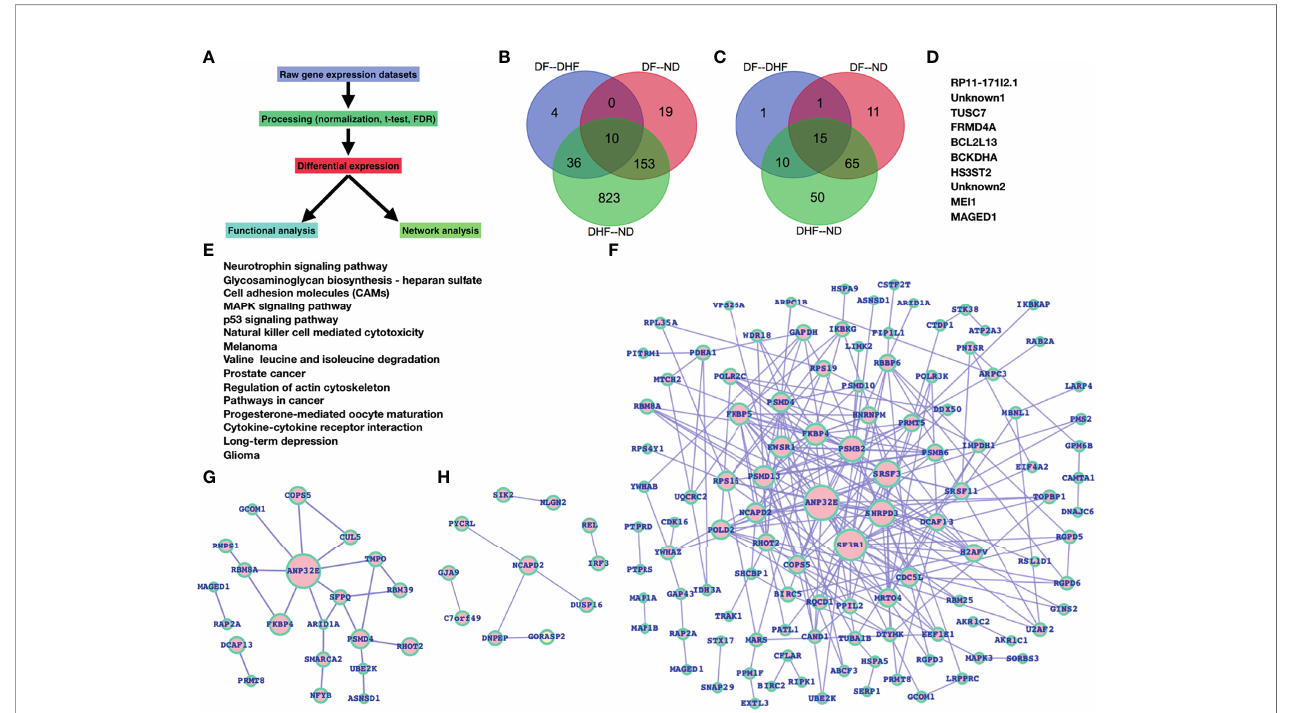
FIGURE 1 | Gene expression pro fi ling in case of dengue infection: (A) work fl ow. Venn diagram for (B) DEGs and (C) inferred pathways. (D) common DEGs between all the samples (E) commonly inferred pathways for all the samples. DEG networks (F) DHF versus ND, (G) DF versus ND, and (H) DF versus